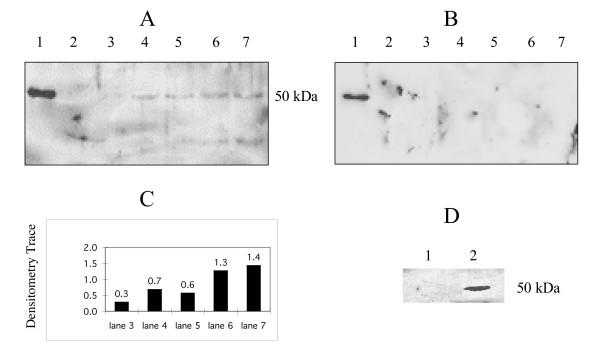
Expression of CYP110 protein in Anabaena 7120. Proteins were fractionated on 12% polyacrylamide gels, blotted to nitrocellulose and probed with rabbit anti-CYP110 antibody. Panel A displays samples treated with 0.2 % n-hexadecane. Panel B, control untreated samples taken at the same time points. Lanes 1 contain 600 ng of purified recombinant CYP110 protein. Lanes 2 are blank. Lanes 3 through 7 contain 50 μg of crude protein taken at 0, 2, 12, 24, and 36 hours. Panel C shows the densitometry trace volumes for the CYP110 protein in Panel A. Panel D is a Western blot showing cyp110-reactive proteins from the 36 hour hexadecane time point after separation into the soluble and membrane fractions. Lane 1: 50 μg of the cytosolic fraction and lane 4: 50 μg of the membrane fraction.